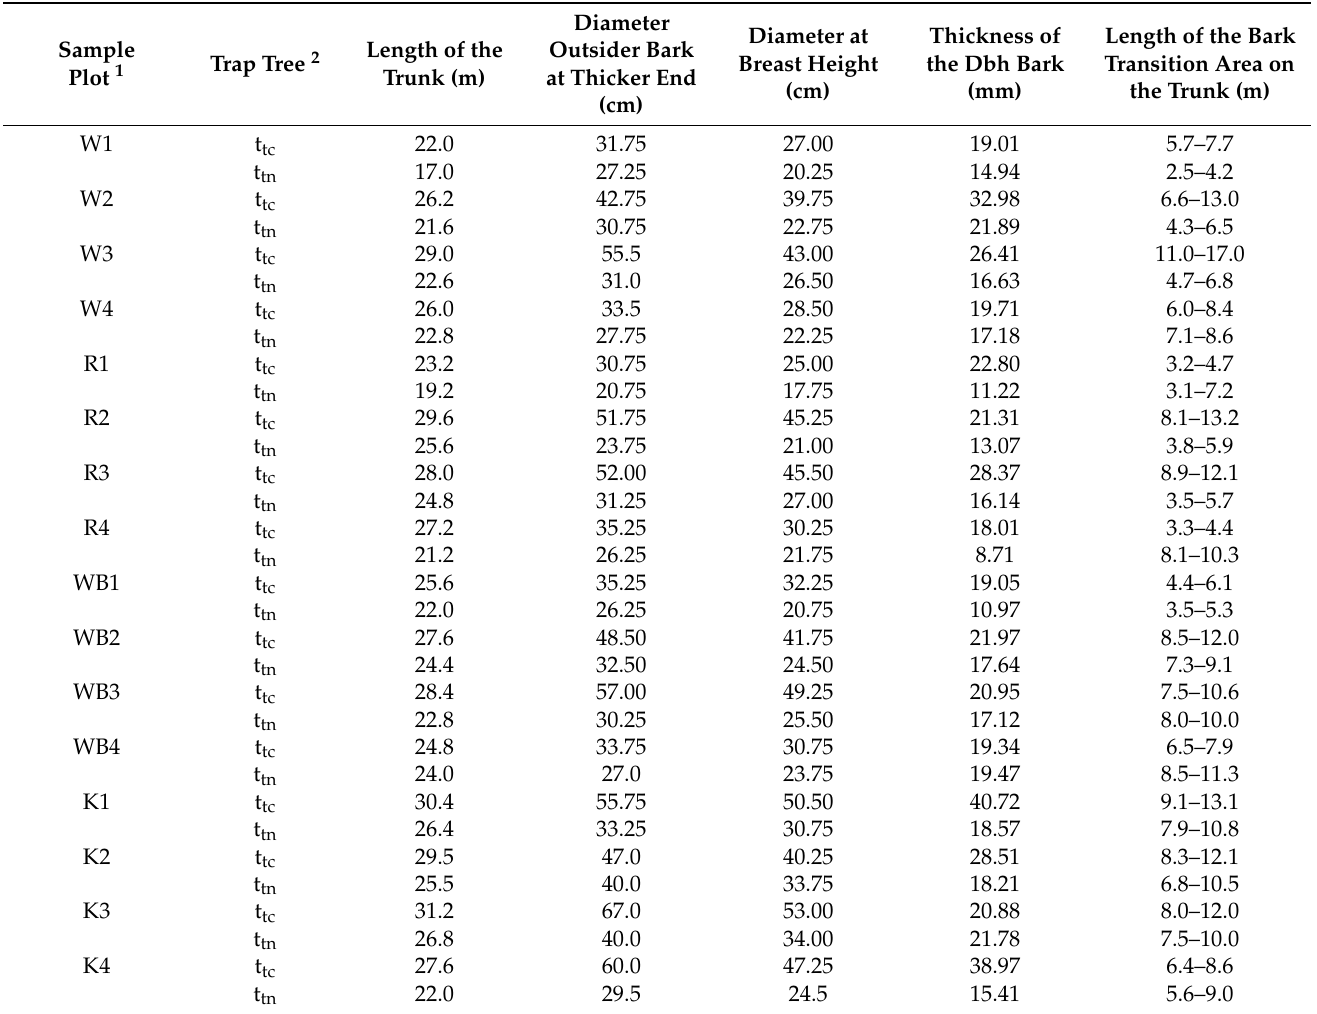
Table 2. Characteristics of Scots pine trap trees felled in the investigated